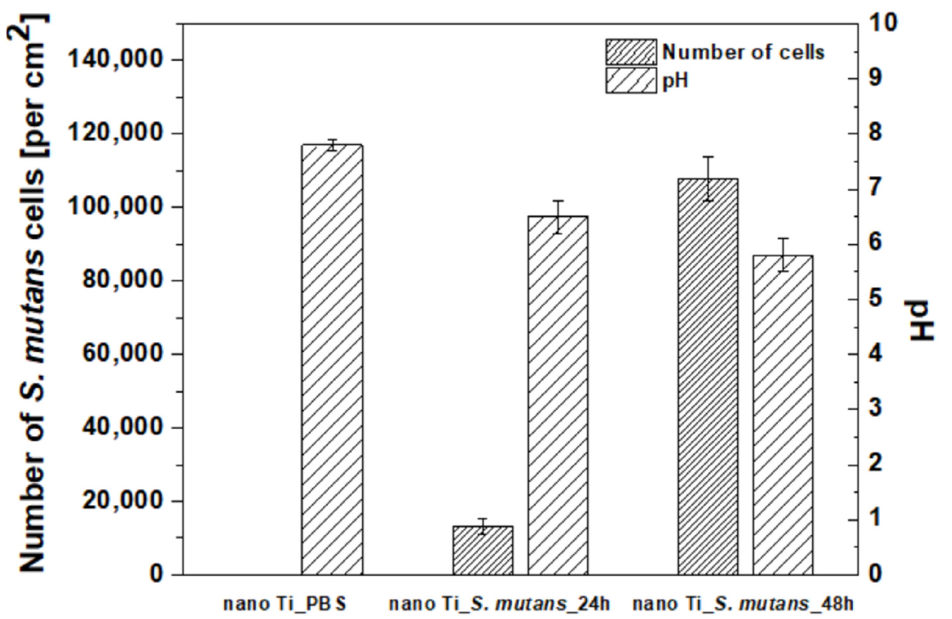
Figure 4. Calculated number of S. mutans cells per 1 cm 2 of nanostructured Ti surface and pH value of the suspension measured after bacterial incubation.